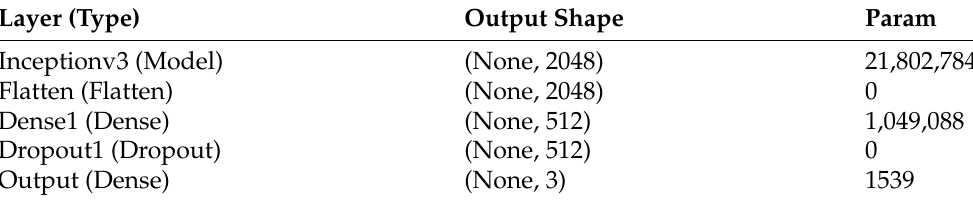
Table A4. Architecture of the CNN used based on Inception v3.